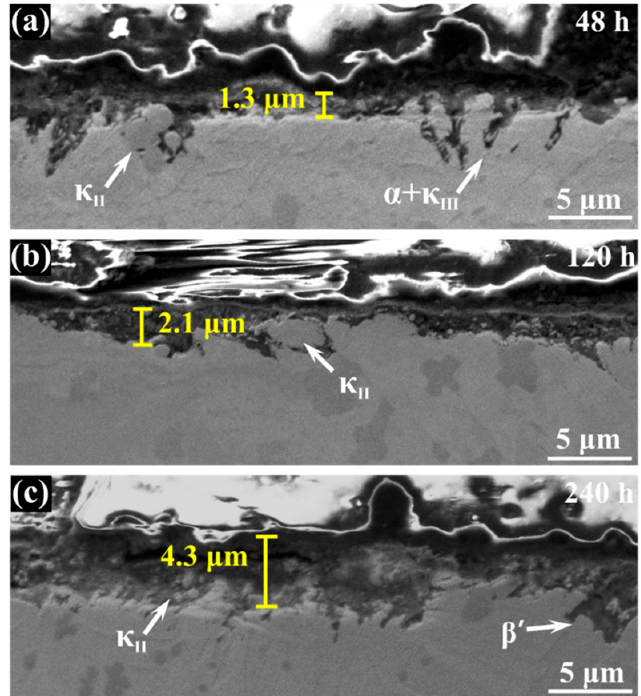
Figure 3. Cross-section morphology of the corrosion product film of NAB alloy after immersion in 3.5 wt % NaCl solution for varying periods of time: ( a ) 48 h; ( b ) 120 h; ( c ) 240 h.